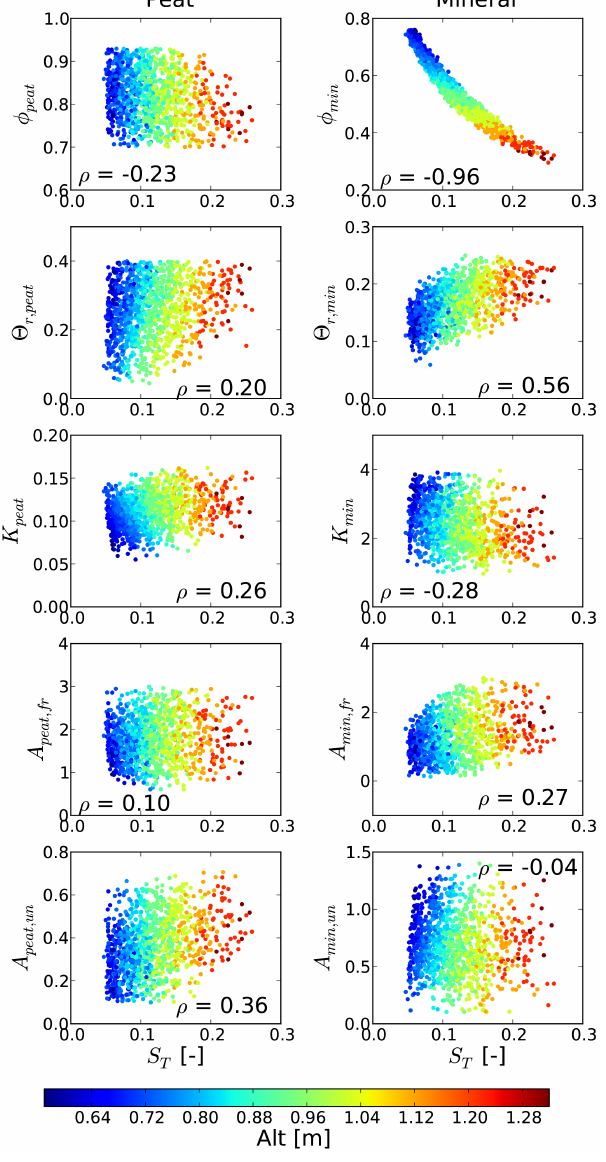
Figure 12. Scatterplots between calibration-constrained parameters and projected Stefan number. Soil parameters associated with peat are on the left and with mineral soil on the right (refer to column headings). Colors represent ALT. The associated Pearson correla- tion coefficient ρ is indicated in each